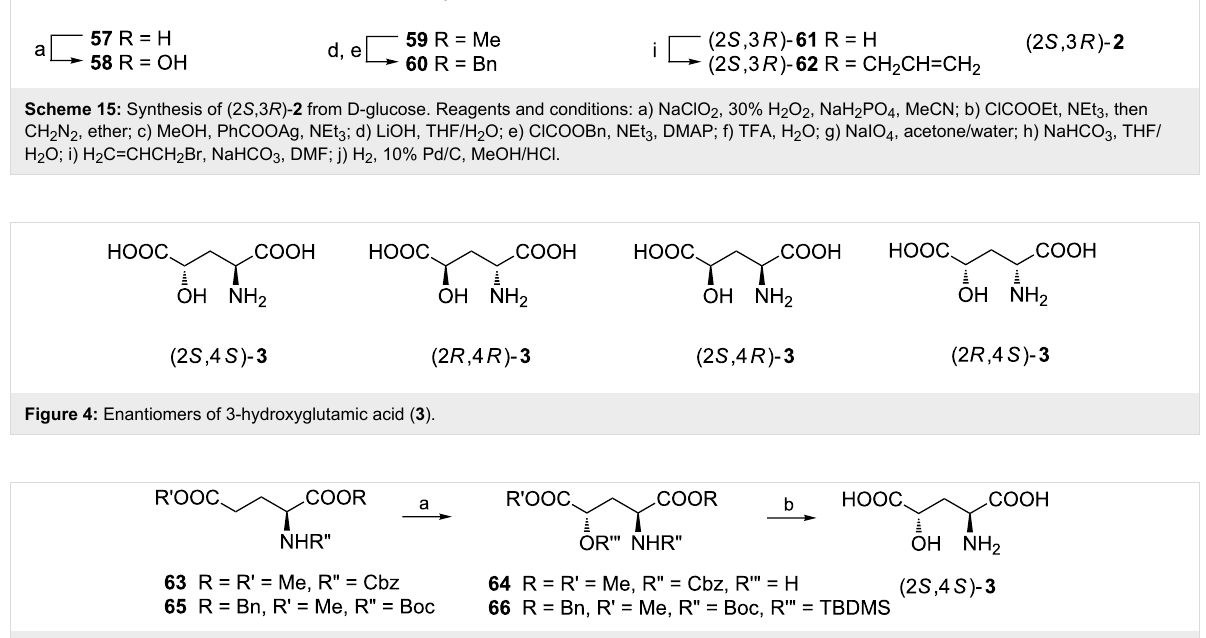
Scheme 16: Synthesis of (4 S )-4-hydroxy-L-glutamic acid [(2 S ,4 S )- 3 ] by electrophilic hydroxylation. Reagents and conditions: a) 3-phenyl- N -phenyl- sulfonyl oxaziridine, then LiHMDS, THF; b) 6 M